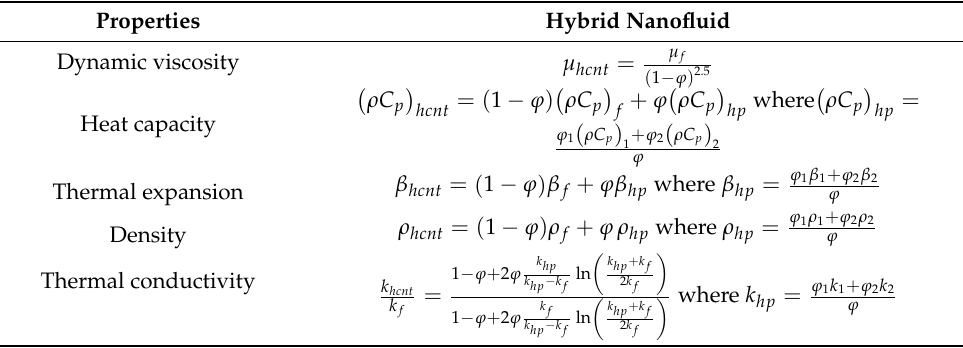
Table 1. Thermo-physical characteristic of hybrid nanofluid.